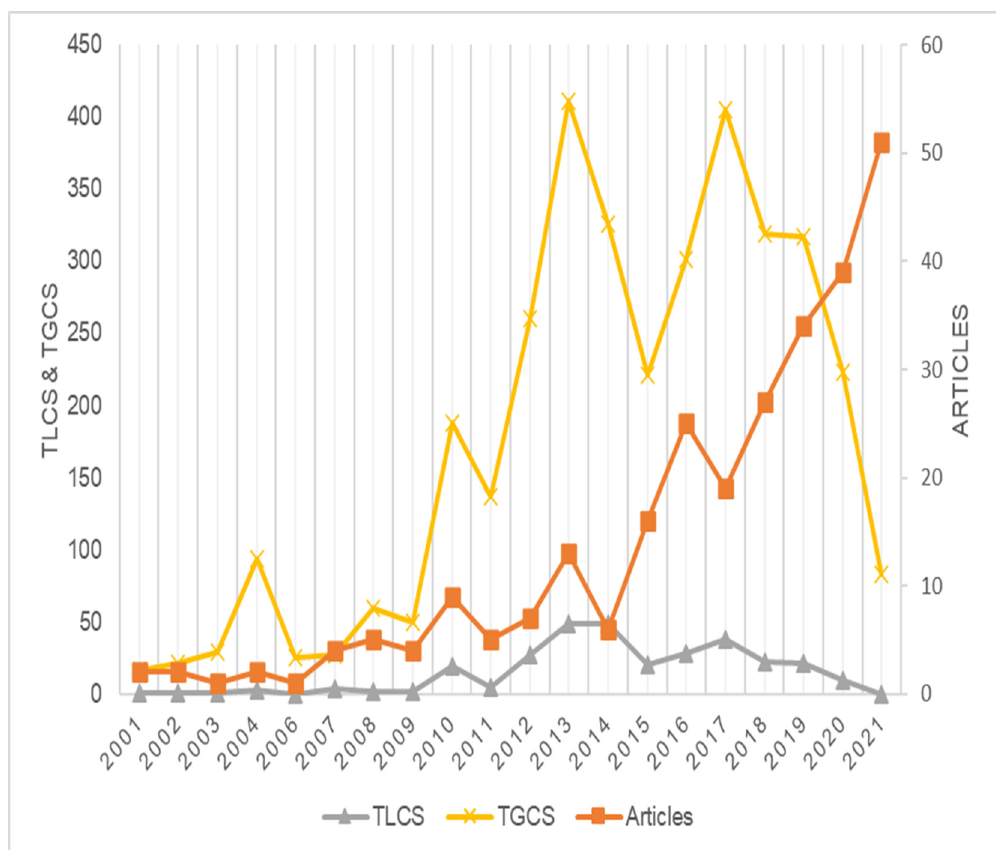
Figure 2. Green port governance literature—total scientific output.